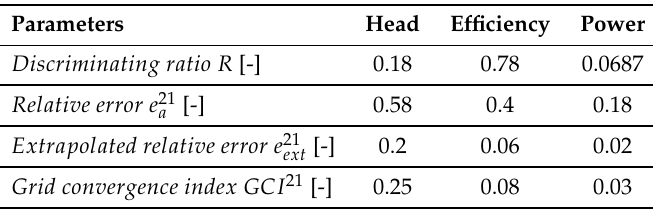
Table 3. Discretization